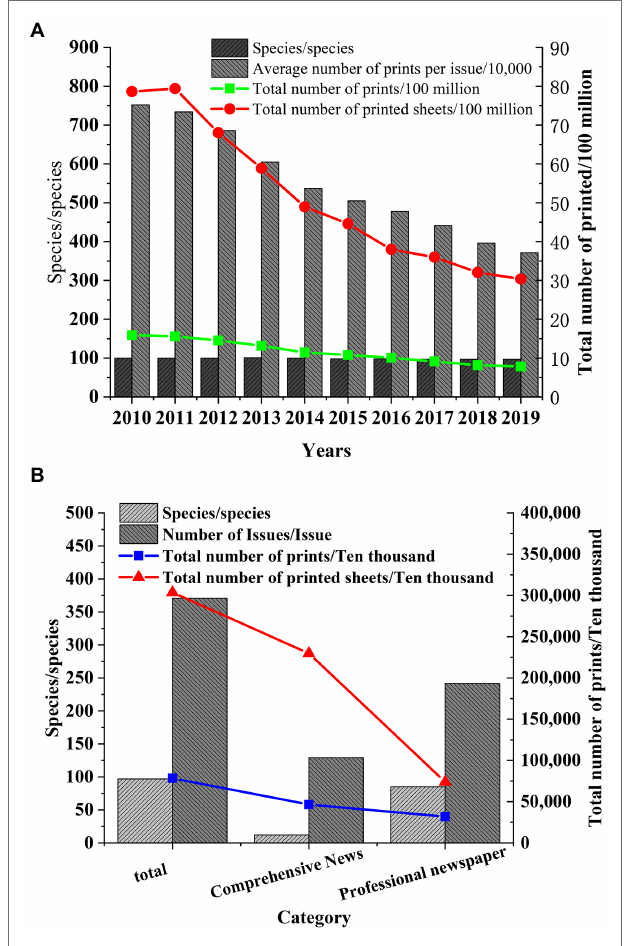
FIGURE 4 | Number of Shanghai newspapers published. (A) Number of Shanghai newspapers published in 2010. (B) Types of Shanghai newspapers published in